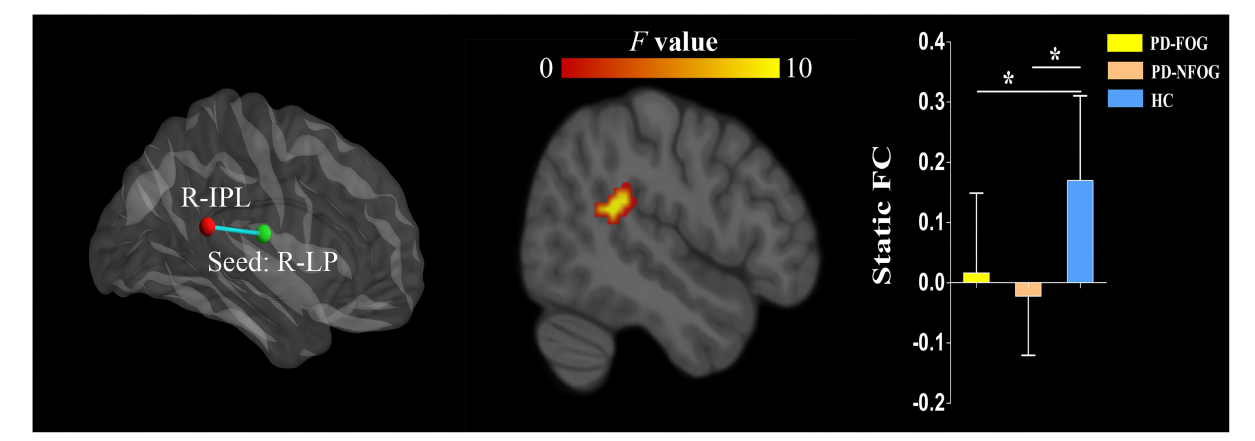
FIGURE 2 | Inter-group differences in static FC of the thalamic nuclei between PD-FOG, PD-NFOG, and HC. FC, functional connectivity; HC, healthy controls; IPL, inferior parietal lobule; LP, lateral posterior nuclei; PD-FOG, Parkinson’s disease patients with freezing of gait; PD-NFOG, Parkinson’s disease patients without freezing of gait; R, right; * p <